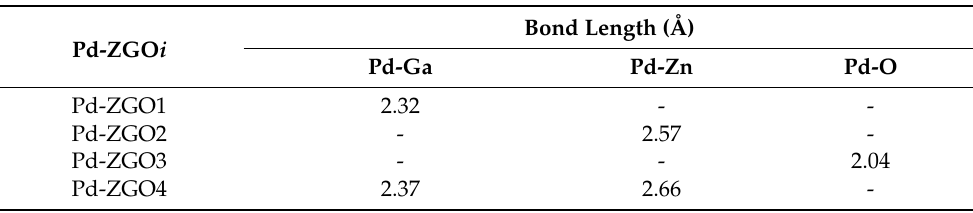
Figure 2. Side view of the Pd atom on ZnGa 2 O 4 (111) surface. Pd-ZGO i , showing Pd atoms located on the top of Ga 3 C , Zn 3 C , O 3 C , and O 4 C sites for i = 1, 2, 3, and 4, respectively. The bond lengths of Pd-ZGO i are listed in Table 1. Table 1. Calculated equilibrium bond length (Å) for the Pd-ZGO i , n NO 2 -Pd-ZGO i , and n H 2 S-Pd- ZGO i structures.